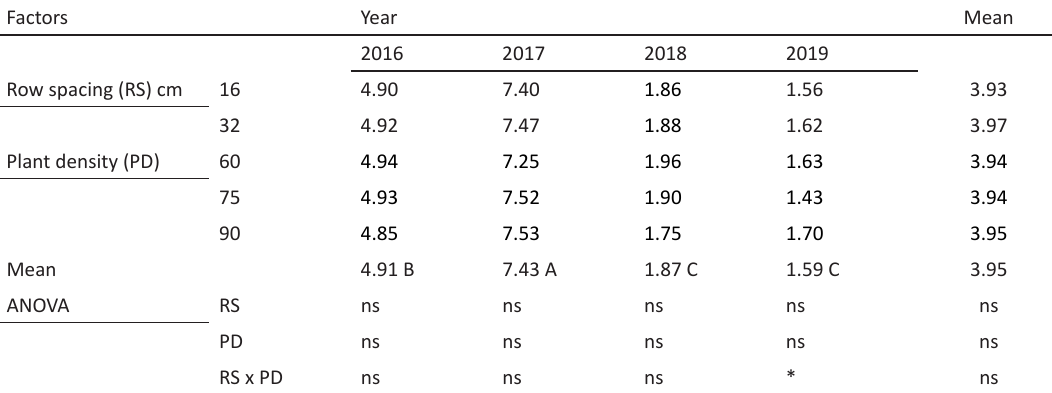
Table 4. Effect of row spacing and plant density on white lupin yield (t ha -1 ) in 2016–2019 Factors Year